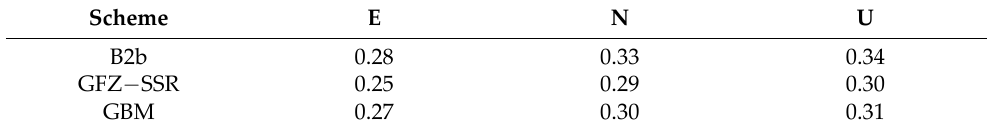
Table 6. RMS statistics of attitude error for the three precise products using tactical IMU (unit: deg).